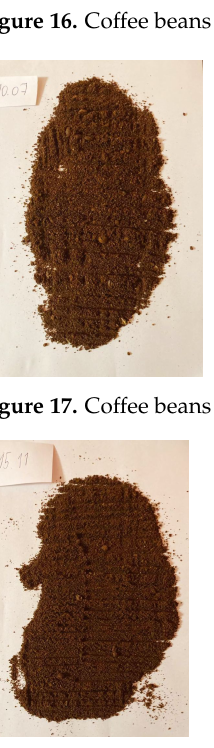
Figure 18. Coffee beans ground for about 15